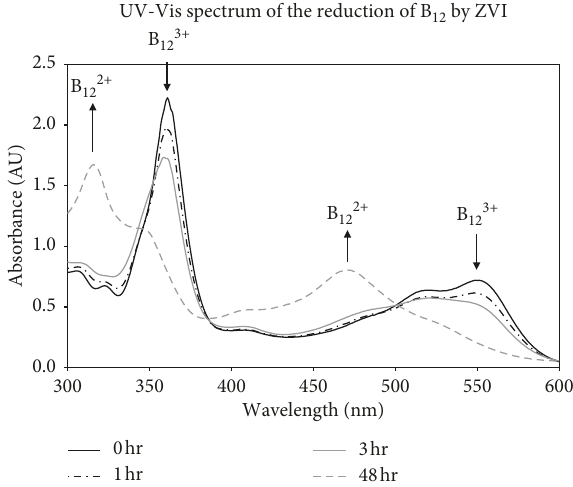
Figure 7: Cobalamin reduction in the presence of µ